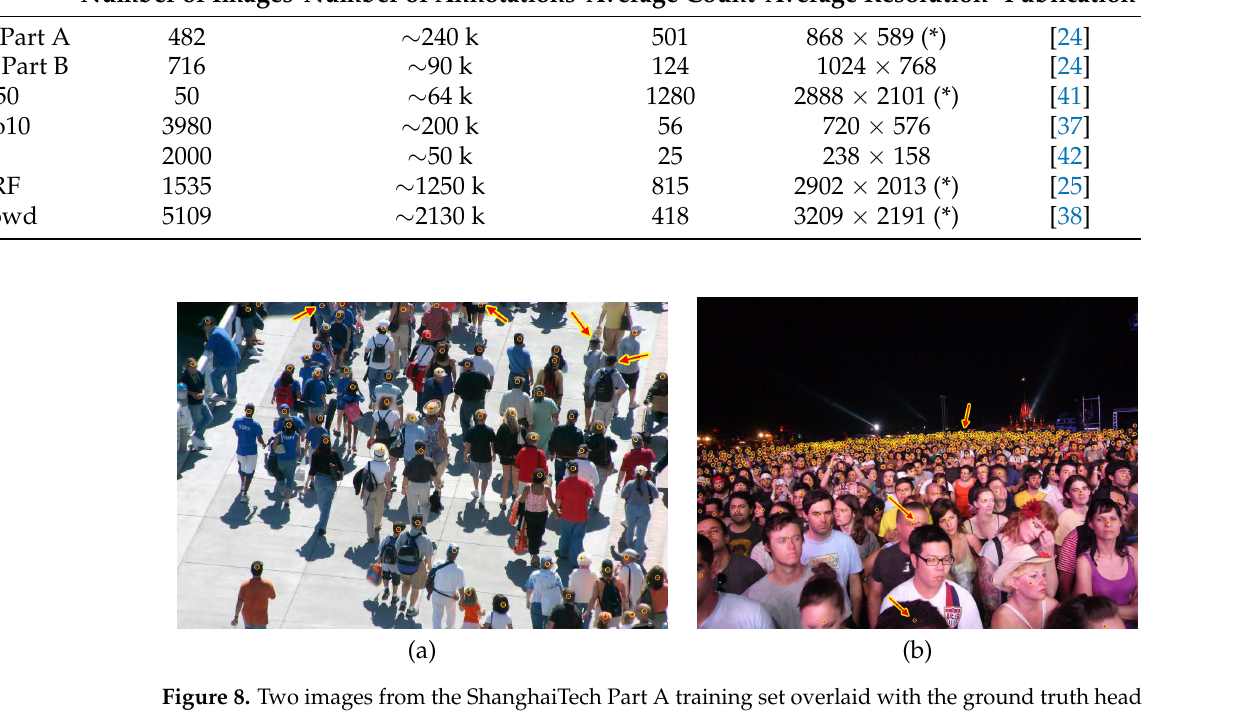
Figure 8. Two images from the ShanghaiTech Part A training set overlaid with the ground truth head annotations (yellow circles with red crosses inside). ( a ) Some annotations are missing and in the upper part there are torsos annotated instead of heads. ( b ) Double annotation and a very inaccurate annotation in the front. Additionally, with increasing distance from the camera the crowd becomes very dense. There, at some arbitrary point in the distance, the labeling